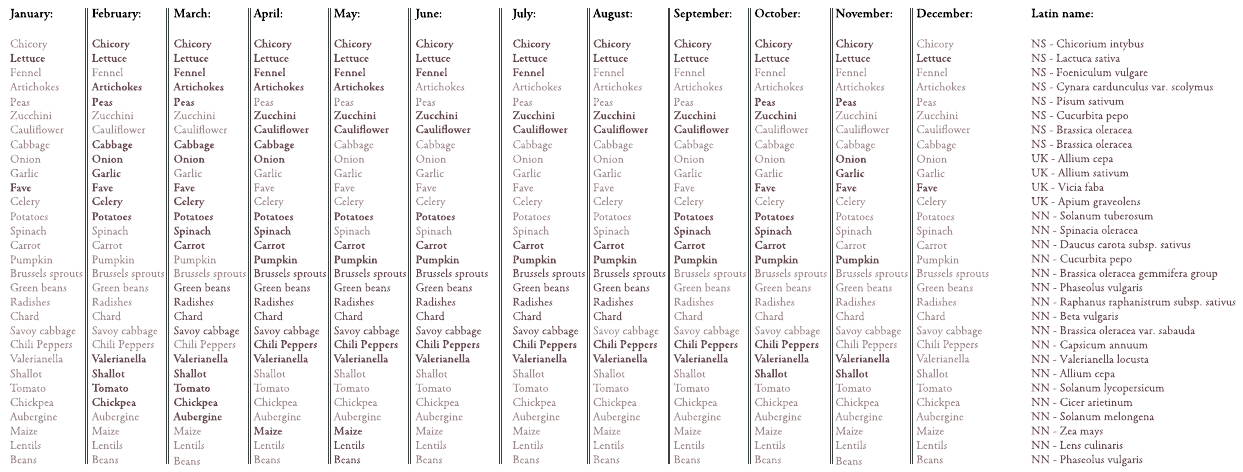
Figure 5. Period of cultivation of vegetables. NS: native species; UK: unknown; NN: not native [12].